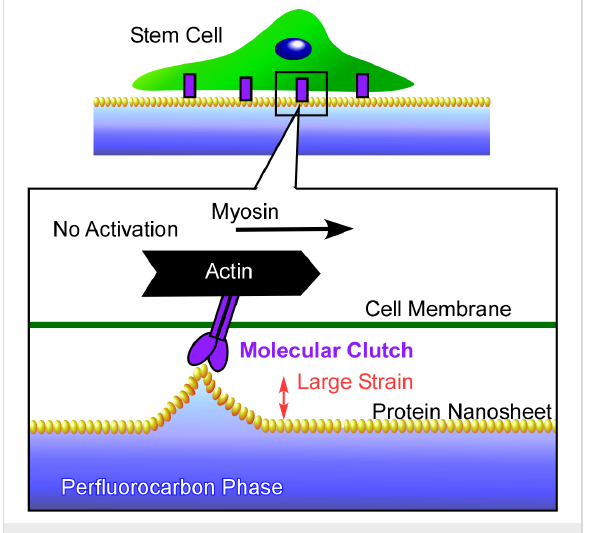
Figure 26: Human mesenchymal stem cells at the interface between aqueous medium and fluorocarbon phase with self-grown two-dimen- sional protein nanosheets at which the mechanical behaviour of cells can be explained by a molecular clutch model.